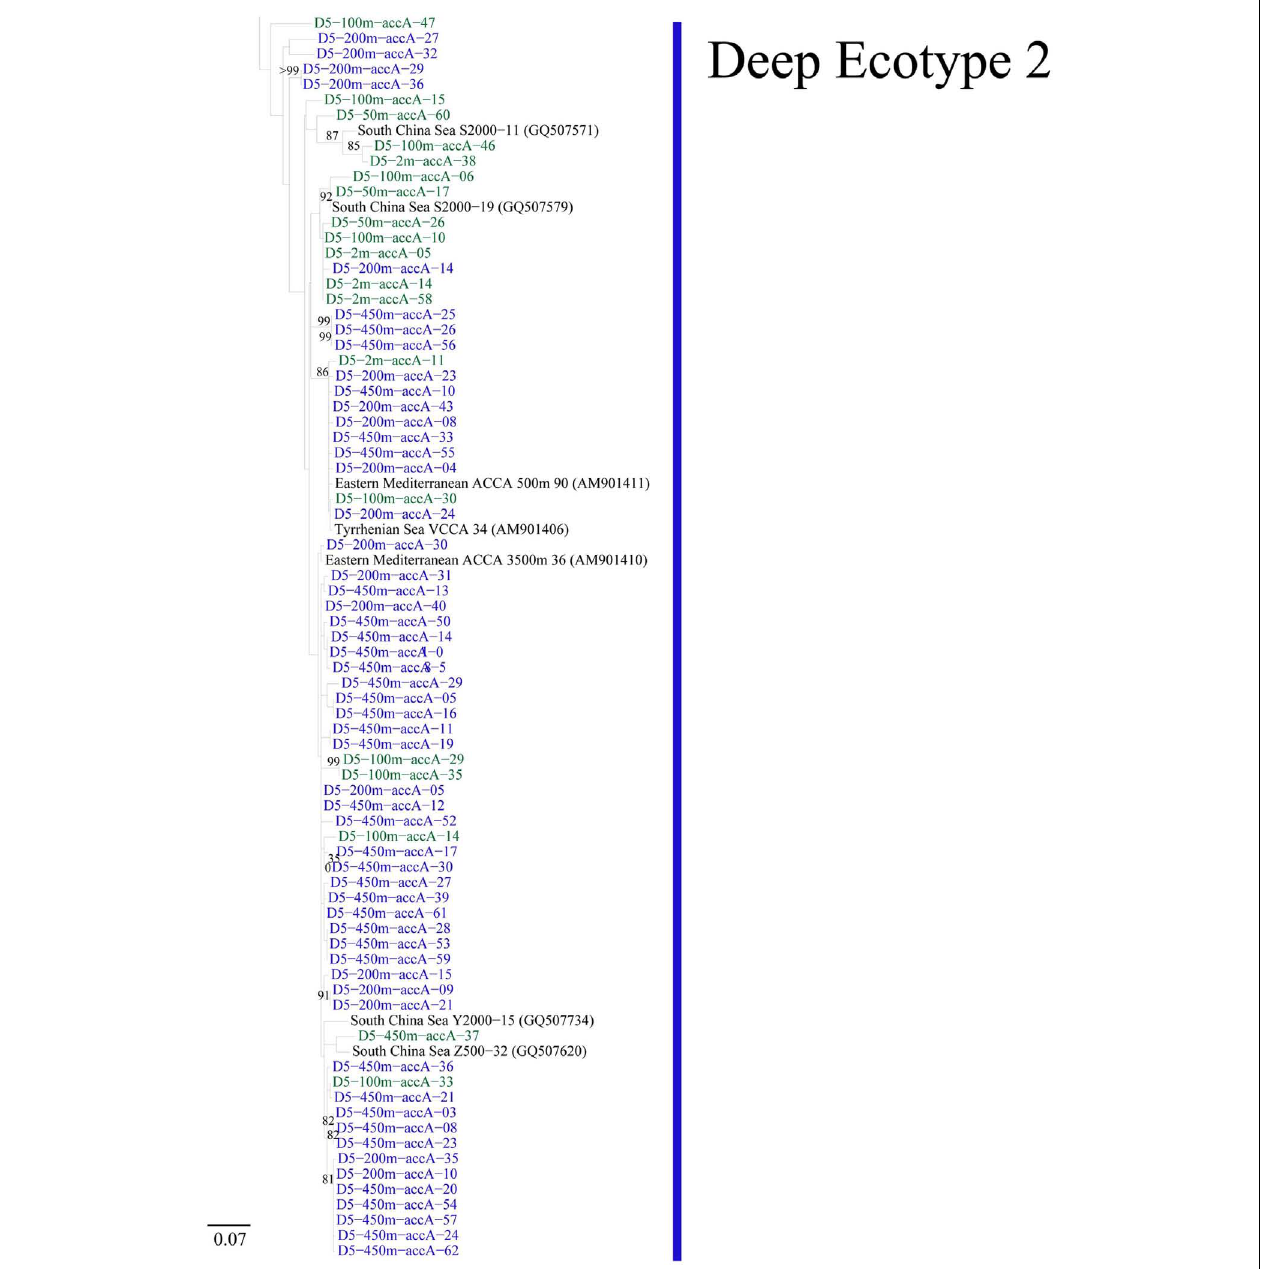
length. Sequences in bold obtained from isolates or enrichment cultures. Bootstrap values obtained from resampling tree 1,000 times; only values above 75% bootstrap support shown on